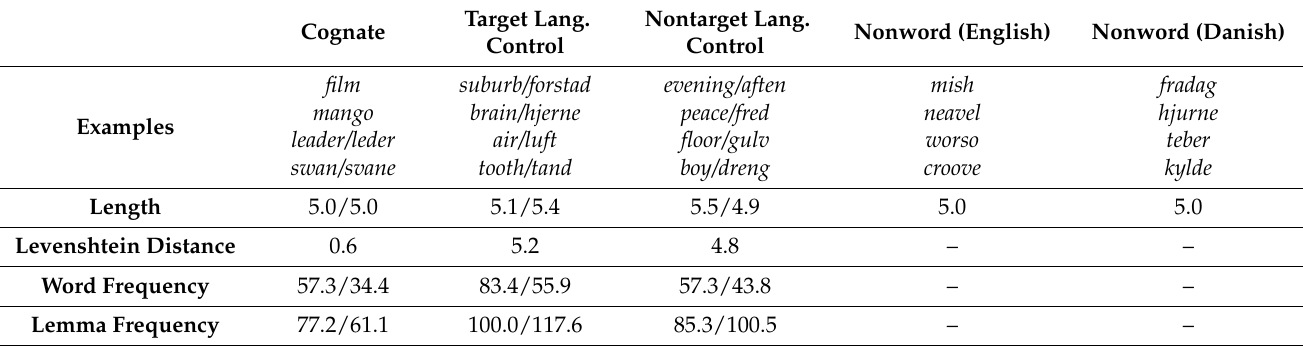
Table 1. Examples of nonwords and translation pairs (English/Danish) across item categories with overall mean word lengths, Levenshtein Distance, as well as word and lemma frequencies (in occurrences per million) for the entire stimulus set. Target Lang. Nontarget Lang. Cognate Nonword (English) Nonword Control Control